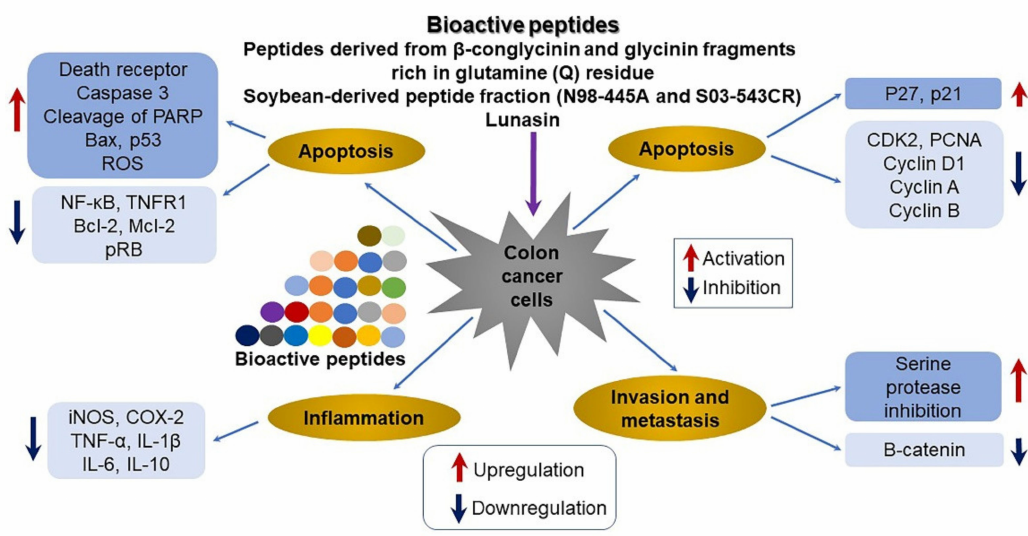
Figure 1. Proposed molecular mechanism associated with bioactive peptides against colorectal cancer. SPs have a critical role in preventive effects by regulating the expression of various genes associated with apoptosis, inflammation, cell cycle arrest, and invasion and metastasis. For apoptosis, these peptides activate death receptor, caspase 3, cleavage of poly (ADP-ribose) polymerase (PARP), Bax, and p53, as well as reactive oxygen species (ROS) accumulation, whereas they inhibit nuclear factor-kappaB (NF- κ B), tumor necrosis factor (TNF) receptor type 1 (TNFR1), Bcl-2, Mcl-1, and phosphorylated retinoblastoma protein (pRB). Regarding inflammation, bioactive peptides suppress the expression of genes involved in inducible nitric oxide (NO) synthase (iNOS), cyclooxygenase 2 (COX-2), TNF- α , and IL-1 β , IL-6, and IL-10. For cell cycle arrest, they upregulate p27 and p21, whereas they downregulate cyclin-dependent kinase-2 (CDK2), proliferating cell nuclear antigen (PCNA), and cyclins (D1, A, and B). Finally, they cause increased serine protease inhibition and decreased β -catenin associated with invasion and metastasis. This figure is adapted from Avil é s-Gaxiola et al.